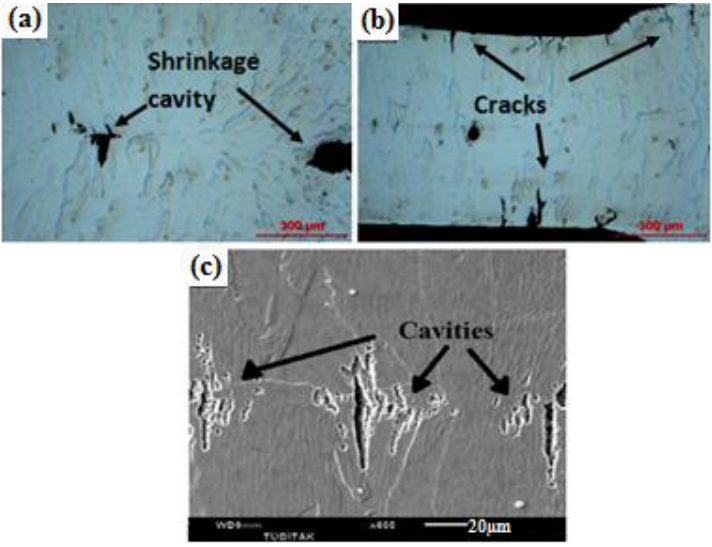
Figure 9. Defects in weld nugget: ( a ) shrinkage cavity; ( b ) cracks; and ( c ) cavities.